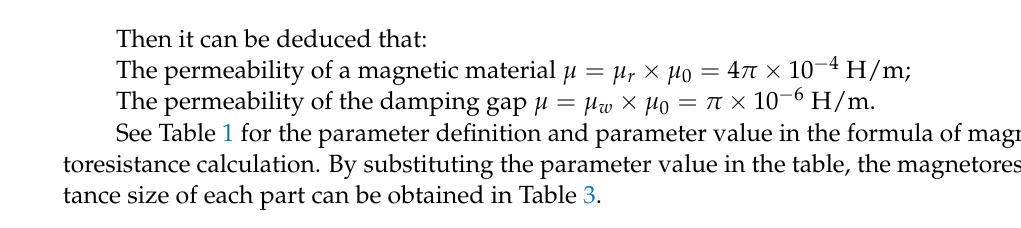
Table 3. Resistance value of each part of valve body. Magnetic